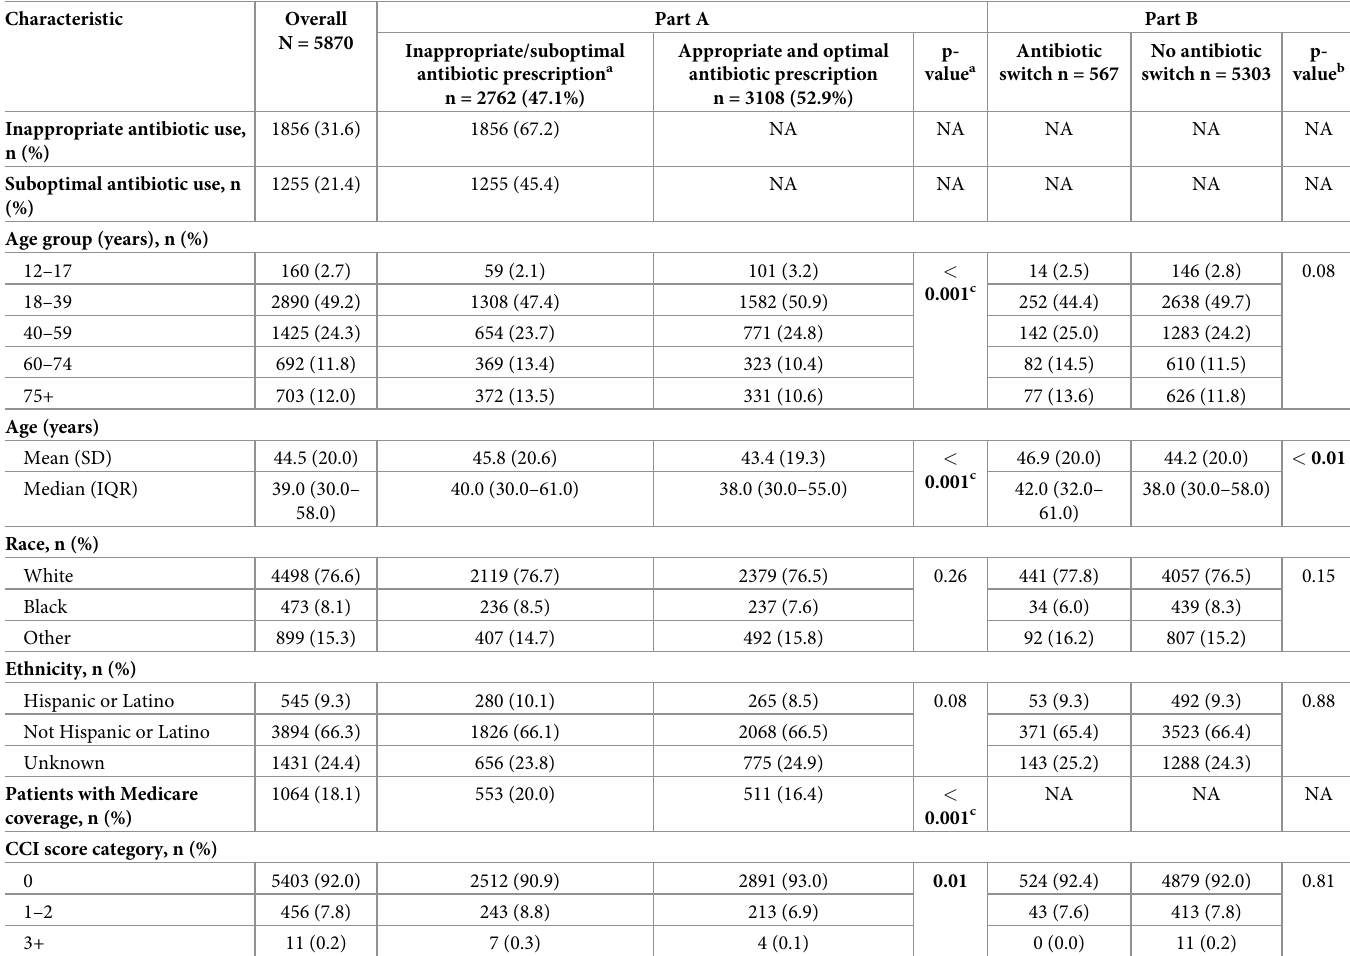
Table 1. Baseline characteristics of patients stratified by appropriateness of antibiotic